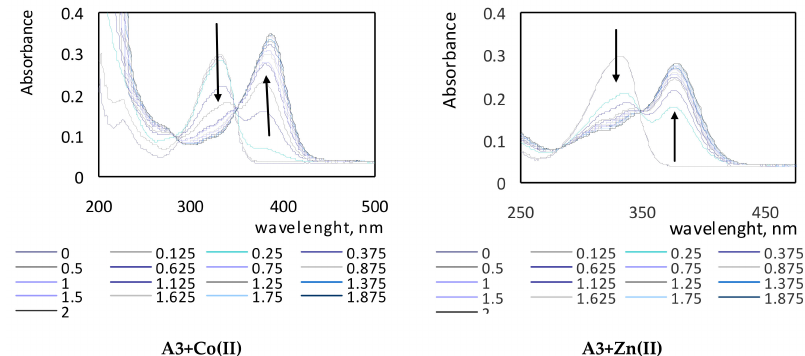
Figure 3. Absorption spectra of complexes of compounds A1–A3 with various metal ions in various molar ratios of ligand to